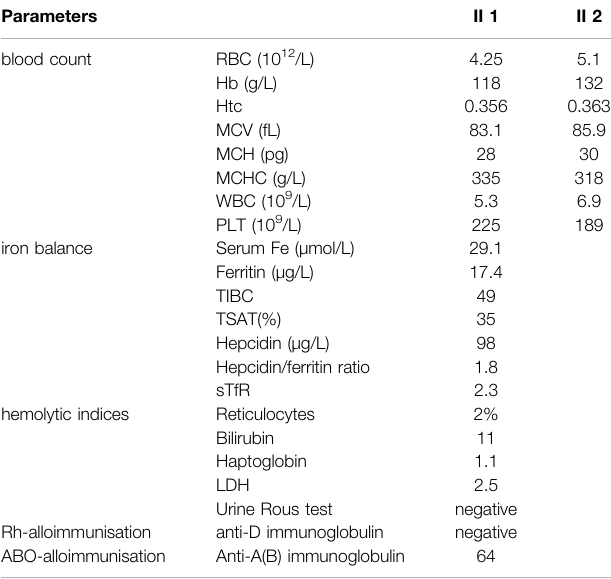
TABLE 1 | Laboratory values of the blood count, the hemolytic indices, the iron balance, and IgG antibody A(B) or antibody